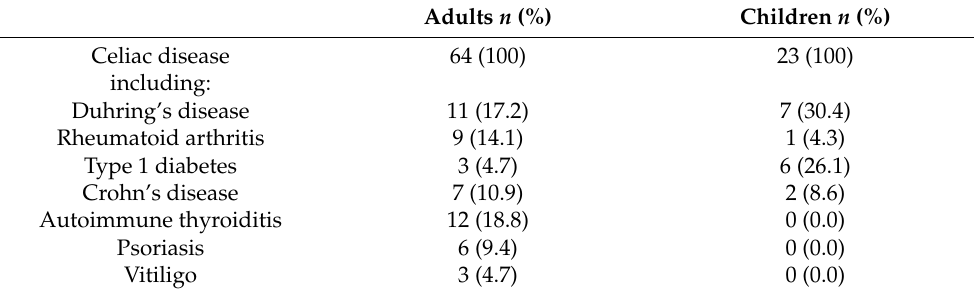
Table 1. Comorbidities with celiac